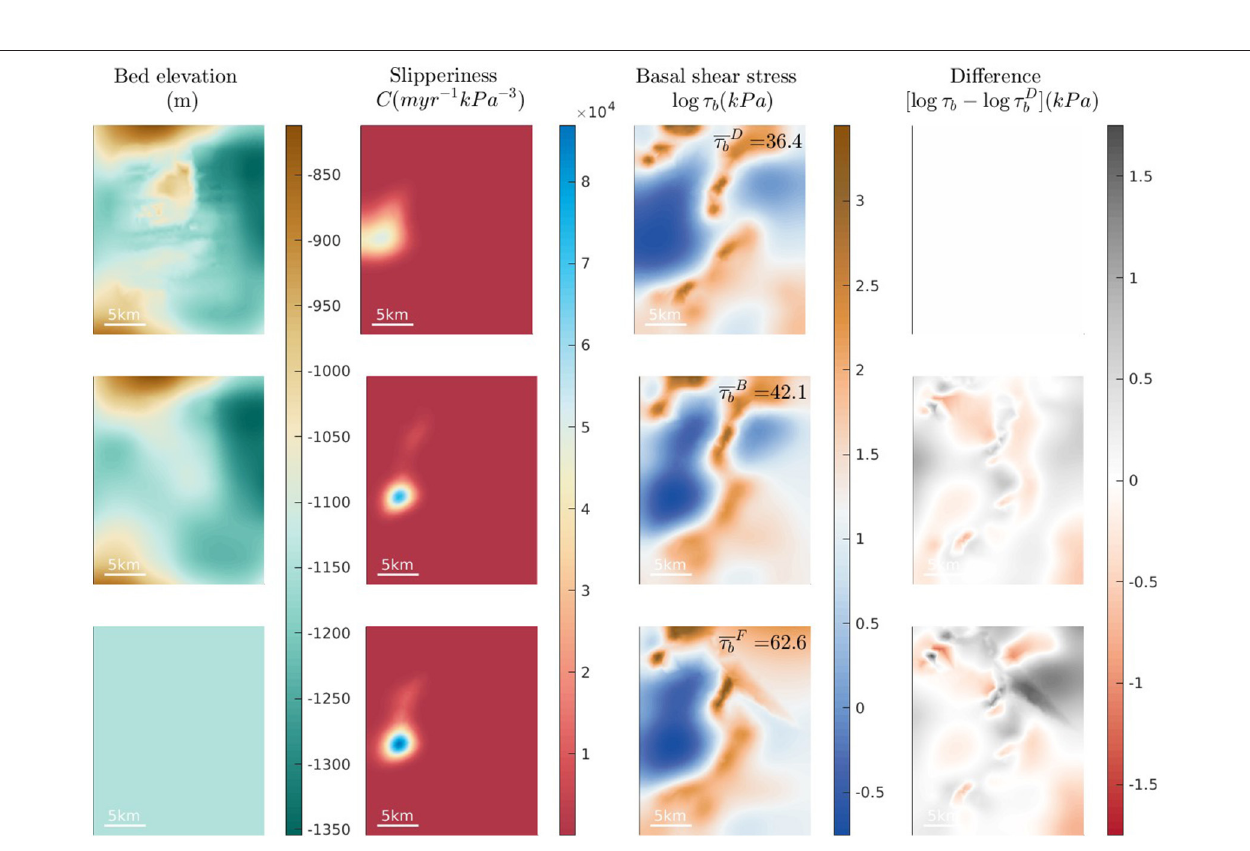
Frontiers in Earth Science | www.frontiersin.org